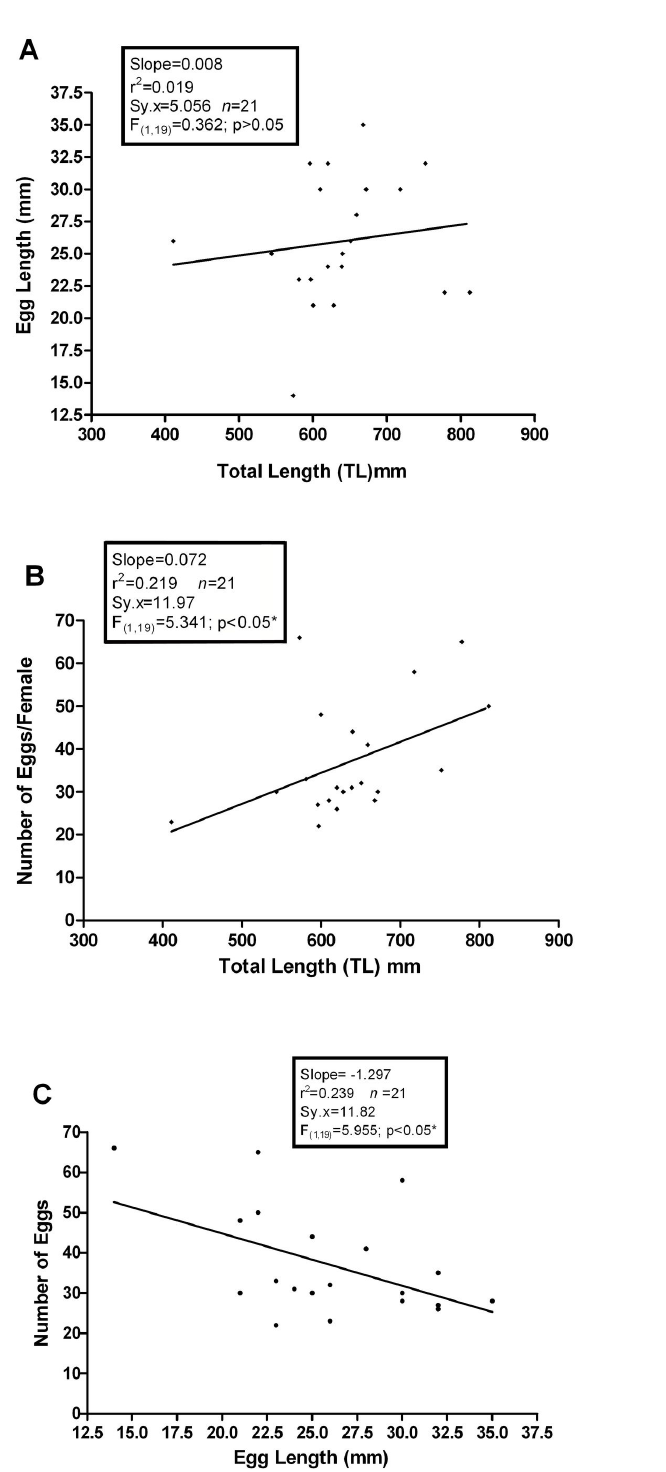
Figure 12. Female reproductive parameters. (a) Egg length as a function of TL. There is no signficant relationship here; larger females do not produce larger eggs than smaller females. (b) Egg number as a function of TL. Large female hagfish produce more eggs than smaller females. (c) A regression of the number of eggs as a function of egg length. For all females, the number of eggs under development decreases as the eggs grow larger. doi: 10.1371/journal.pone.0078740.g012 PLOS ONE |